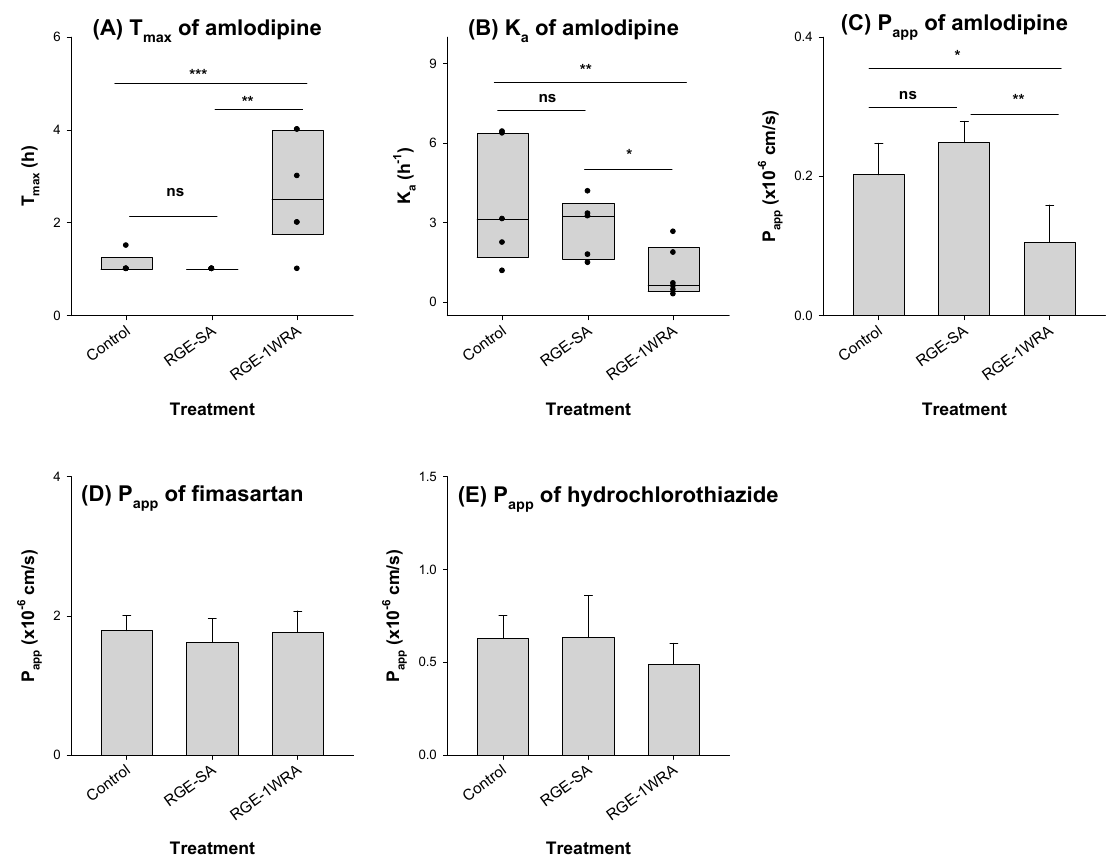
Figure 5. Comparison of ( A ) T max and ( B ) K a values of amlodipine in rats orally administered vehicle (control group), single-dose RGE (1.5 g/kg; RGE-SA), and repeated-dose RGE (1.5 g/kg, once daily for one week; RGE-1WRA). Permeability (P app ) of ( C ) amlodipine, ( D ) fimasartan, and ( E ) hydrochlorothiazide in the jejunum of rats following the oral administration of vehicle (control group), single-dose RGE (1.5 g/kg; RGE-SA), and repeated-dose RGE (1.5 g/kg, once daily for one week; RGE-1WRA) was measured using the Ussing system. p -values were obtained from post-hoc analysis following the Kruskal ‒ Wallis test. * p < 0.05, ** p < 0.01, and *** p < 0.001. Data represent the mean ± standard deviation ( n = 5 for T max and K a ; n = 4 for permeability).